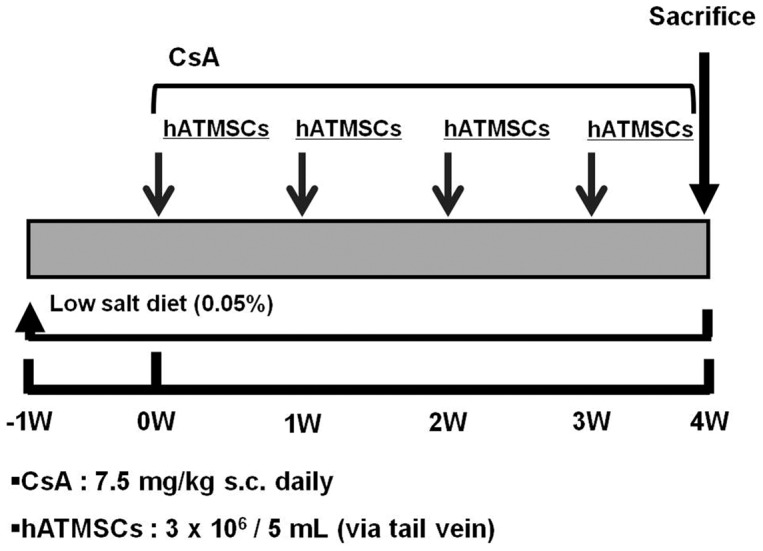
Experimental design in this study.CsA was administered at a dose of 7.5 mg/kg subcutaneously daily. hATMSCs was infused at 0,1,2 and 3 weeks from the start of CsA with cell number of 3×106/mL via tail vein. hATMSCs; human adipose tissue derived mesenchymal stem cells.